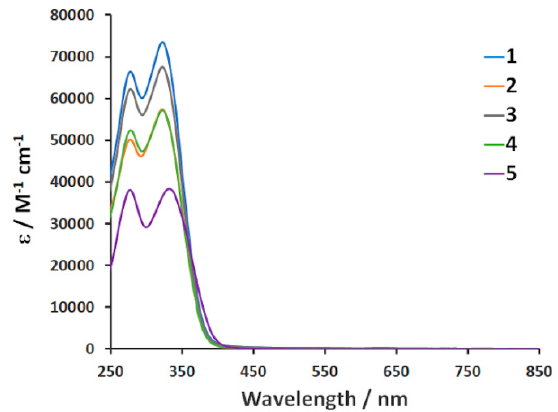
Figure 1. UV–VIS spectra of fac -[Fe(4-ima-Bp) 2 ](Y) 2 · sol 1 – 5 in MeOH.